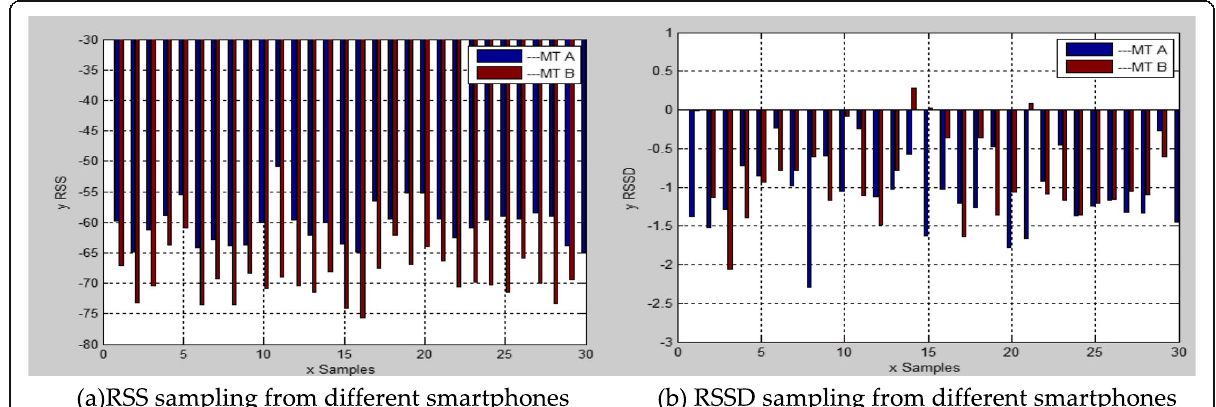
Fig. 4 Robustness comparison between RSS and RSSD. a RSS sampling from different mobile terminals. b RSSD sampling from different mobile terminals.